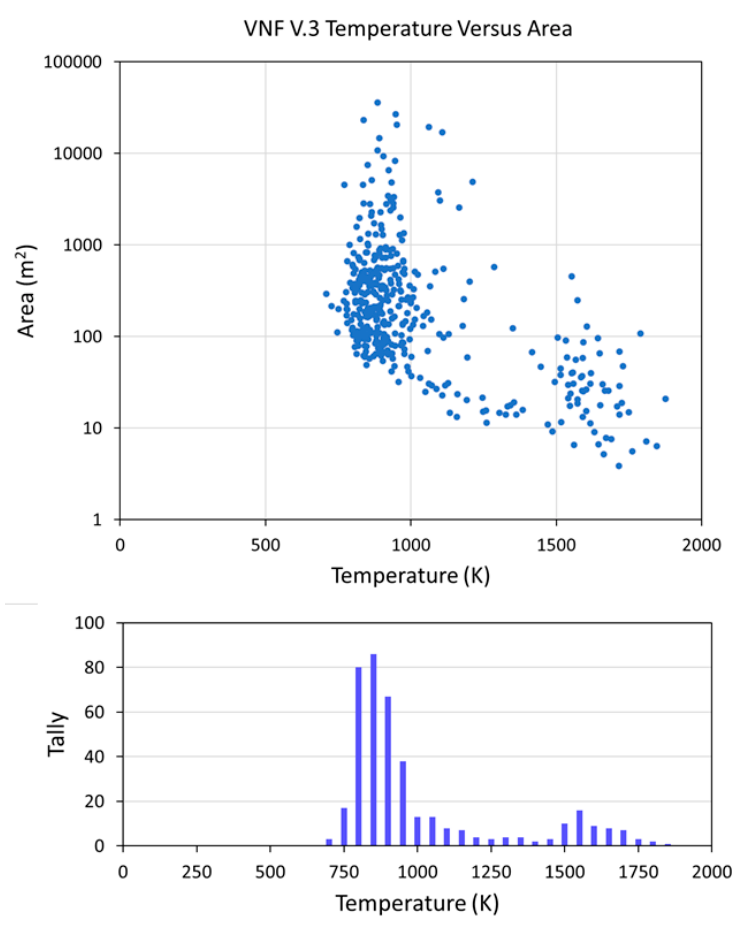
Figure 16. VNF v.3 temperature versus area scattergram and temperature histogram for the Type 4 detections from the three test sites. detections from the three test